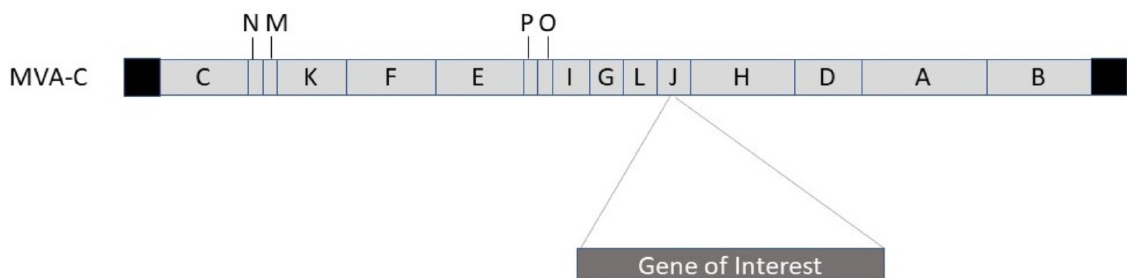
Figure 2. Vaccinia virus (MVA-C) expression vector engineered for recombinant protein expression. Structural MVA genes A, B, C, D, E, F, G, H, I, J, K, L, M, N, O, and P indicated. The gene of interest is introduced into the J